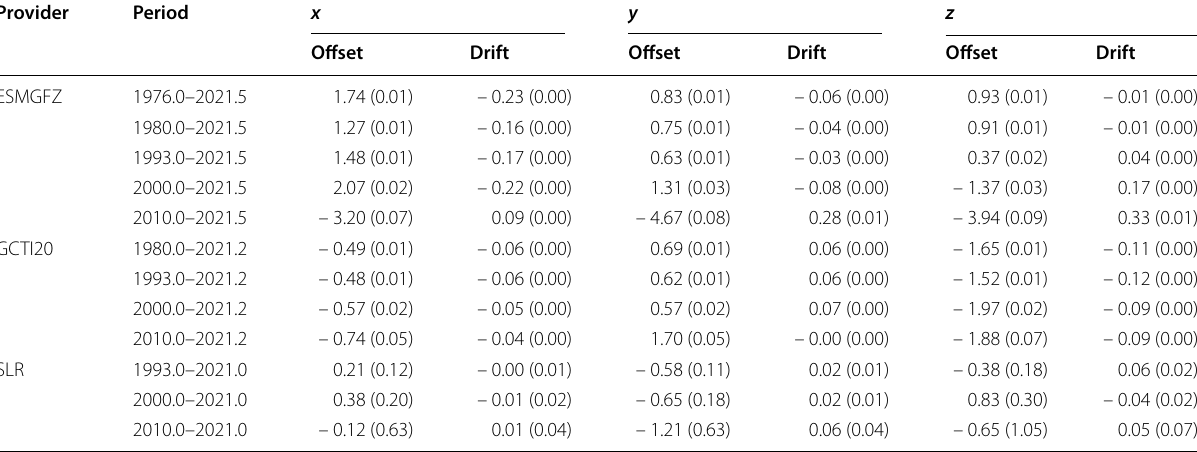
Table 2 Fitted trends (offsets at 2000.0 in [mm], and drifts in [mm/year]) for the geocenter motion as computed from ESMGFZ, GCTI20, and ILRS data (see text). In each case, the trends have been fitted from the corresponding time-series period listed in column ”period”. Formal errors are given in